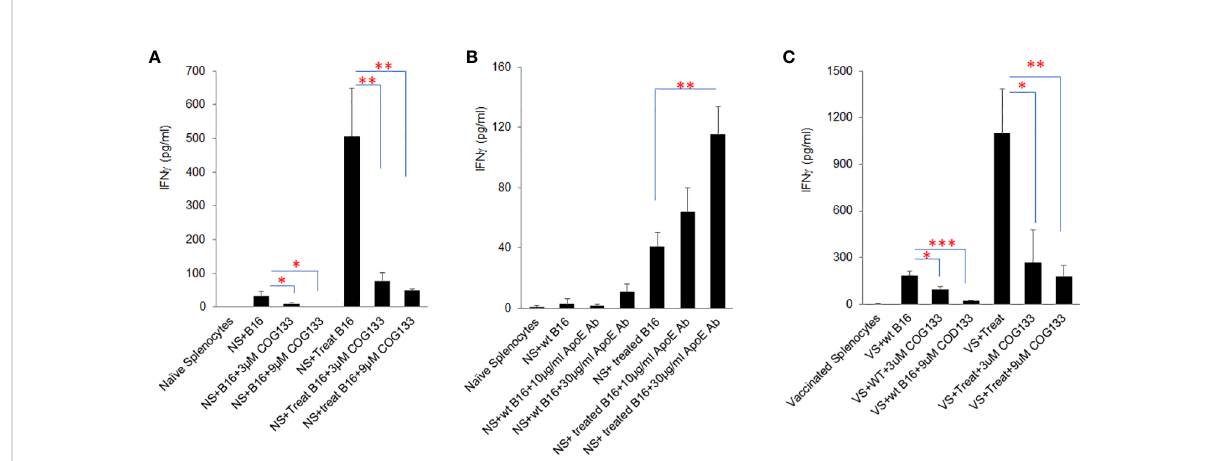
FIGURE 3 ApoE agonist peptide COG133 inhibits cytokine secretion induced by immunogenic tumor cells, while anti-APOE blocking antibody enhances cytokine secretion in tumor cell/splenocyte reactions. (A) Naïve and vaccinated splenocyte production of IFN g was markedly reduced when splenocytes were co-cultured with immunogenic (BET/JQ1 treated) B16 tumor cells in the presence of the apoE agonist COG133. (B) Naïve splenocyte production of IFN g was signi fi cantly increased when co-cultured with immunogenic B16 tumor cells with anti-APOE antibody. (C) . COG133 was also inhibitory of IFN g production when vaccinated splenocytes were used for co-culture with treated immunogenic cancer cells. It is of interest to note that the levels of IFN g production is signi fi cantly greater when vaccinated splenocytes were used for this experiment. NS: naïve splenocytes, splenocytes were collected from naïve C57BL/6 mice. Treated B16: B16 cells were expose to Myc inhibitor (0.25µM BET and 0.25µM JQ1) for 4 days, to induce immunogenicity. VS: vaccinated splenocytes. Irradiated 10 4 WT B16 tumor cells and 100ug/ ml anti-CTLA4 antibody were administered to C57BL/6 mice on day 0, and splenocytes were collected at day 7 after tumor cell inoculation. Data are representative of three independent experiments. Results are expressed as mean score ± SD. *p<0.05; **p<0.005; ***p<0.001, determined by unpaired two-tailed Student ’ s